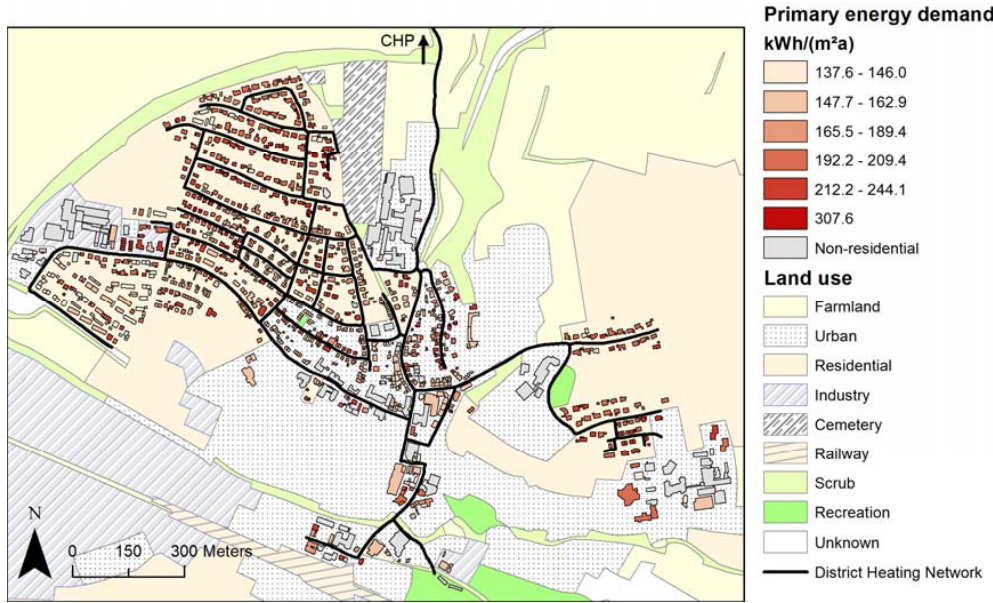
Figure 4. Study region including land use, building footprints and district heating network.